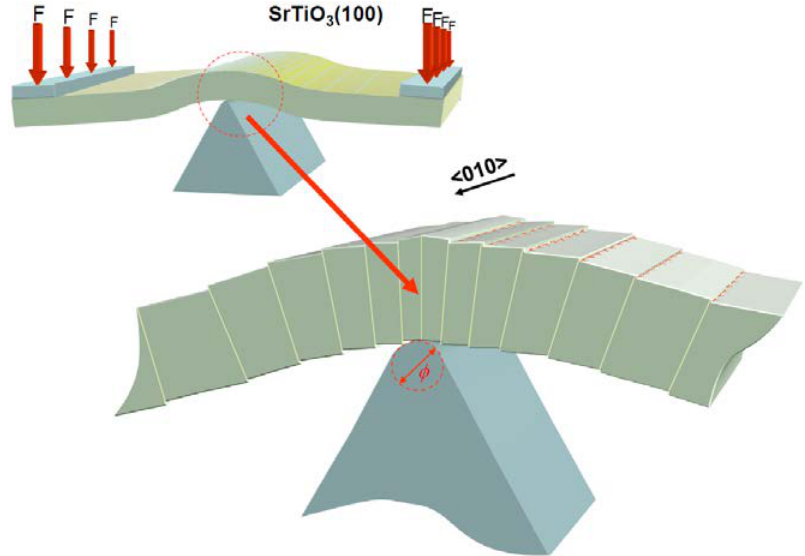
Figure 67. Visualization of the device which has been used for the plastic deformation of the SrTiO 3 crystals. The strength of the deformation can be controlled by external forces and curvature of the part of prism which is in a direct contact with the bottom of the crystal.